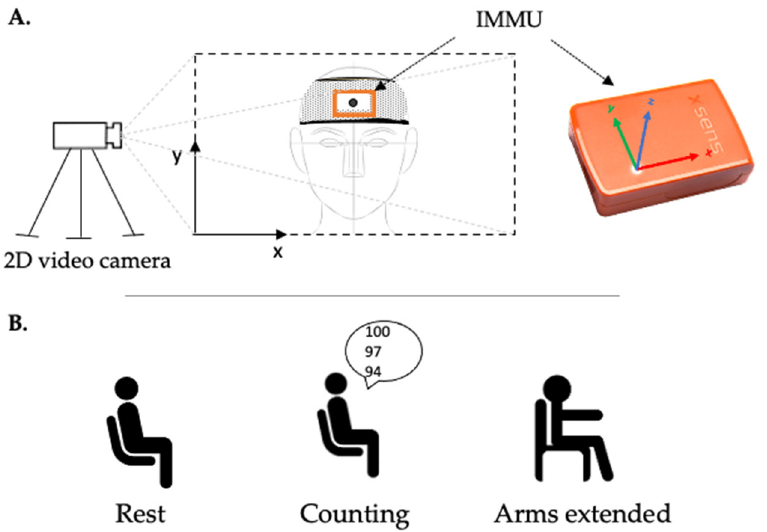
Figure 1. Schematic representation of the experimental setup. ( A ) The IMMU was mounted on the forehead using a disposable headband above the eyebrows to measure the angular displacements of the head. A video camera was placed on a tripod in front of the patient in order to focus on the participant’s face. A black marker on a white background was positioned over the IMMU to track the two-dimensional linear displacements of head motion by the camera. ( B ) Video and IMMU data were simultaneously collected in three successive conditions: at rest in a sitting position for 60 s, for 30 s of backward counting aloud, and with arms outstretched against gravity (arms extended) for 30 s.